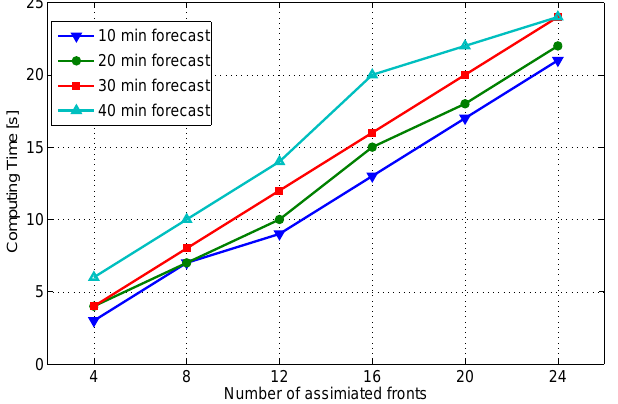
Figure 6. Computing time required for four different forecasting time lengths (10, 20, 30 and 40min) versus the number of assimi- lated fire fronts.